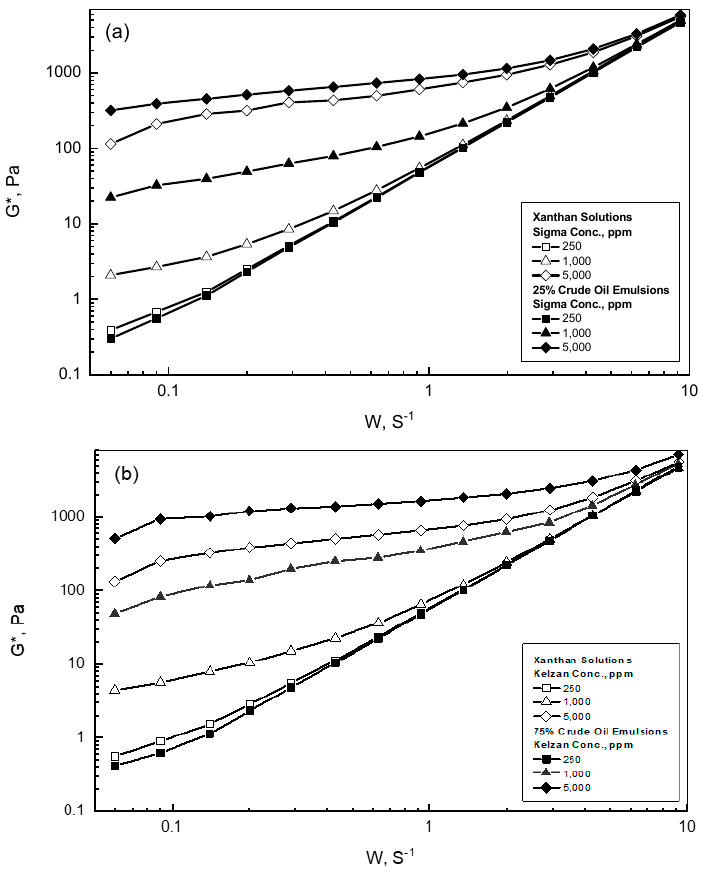
Figure 2. G* different behaviors of xanthan solutions and emulsions. ( a ) 25% crude oil emulsions; ( b ) 75% crude oil emulsions. Figure 3 emphasizes the role of the crude oil addition into two different concentra- tions of Sigma solutions. The measured complex modulus increased gradually with crude oil addition over the range of 0–75% by volume of crude oil. For the 10 3 ppm Sigma solu- tion, the addition of 25% crude oil increased the measured G * considerably in comparison with its solutions. The greater addition of 75% crude oil slightly increased the measured G *. Similar observations are presented in Figure 3 for the 5000 ppm Sigma solution. As can be noticed from Figure 3, the addition of the crude oil droplet phase significantly boosted the complex modulus. The influence of the crude oil addition could be due to the interactions of the oil droplet distributed phase and the xanthan continuous phase. The greater the amount of crude oil involved, the higher the result for G *. The presence of the